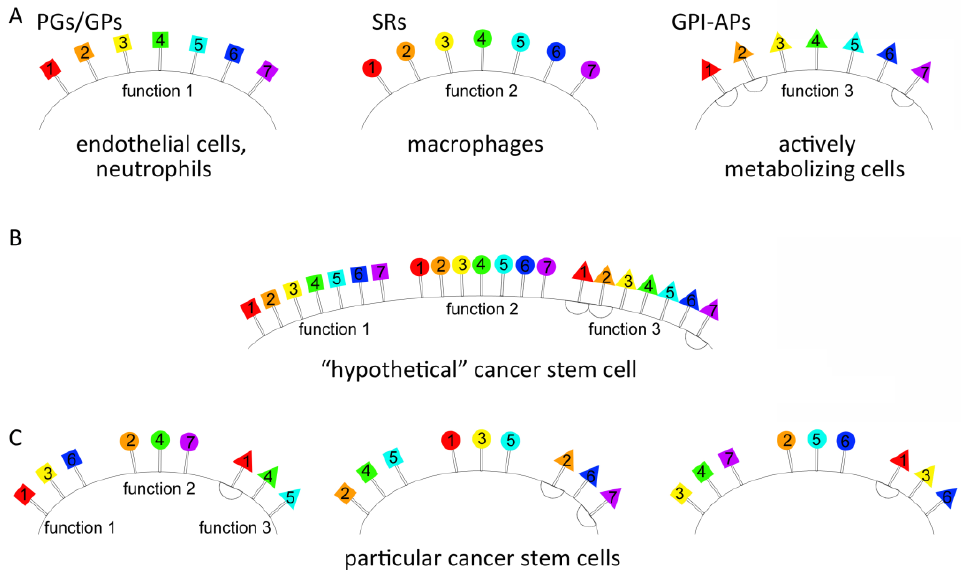
Figure 3. The principle of molecular organization of a “stem cell”, which determines its surface molecular profile and consists of two postulates. Molecular organization of surface proteins in tumor stem-like cells is based on the fact that three functional groups of proteins need to be present on their surface. These groups need to retain their functional properties, regardless of their internal composition, which may differ, thereby forming a unique surface profile in tumor stem-like cells from both multiple and single tumors. ( A ) Specialized cells with particular functions also exerted by cancer stem cells. The geometric figures and numbers correspond to specific protein groups providing an appropriate functionality characteristic of the indicated cell type. Squares — proteoglycans/glycoproteins (PGs/GPs); circles — scavenger receptors (SRs); triangles — glycosylphosphatidylinositol-anchored proteins (GPI-APs). ( B ) The molecular profile of the surface of a “hypothetical” cancer stem cell. ( C ) The molecular profiles of the surface of particular cancer stem cells.